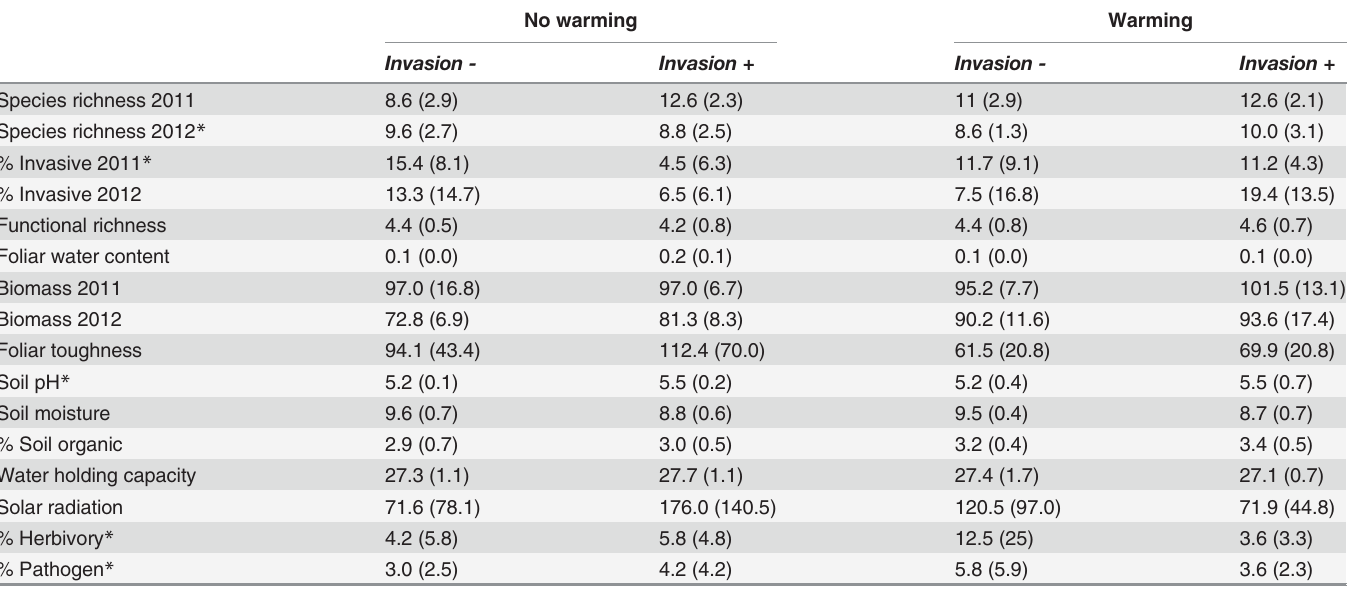
Table 2. Means and (SD) for environmental factors from plots exposed to the warming treatment (data from nitrogen addition plots